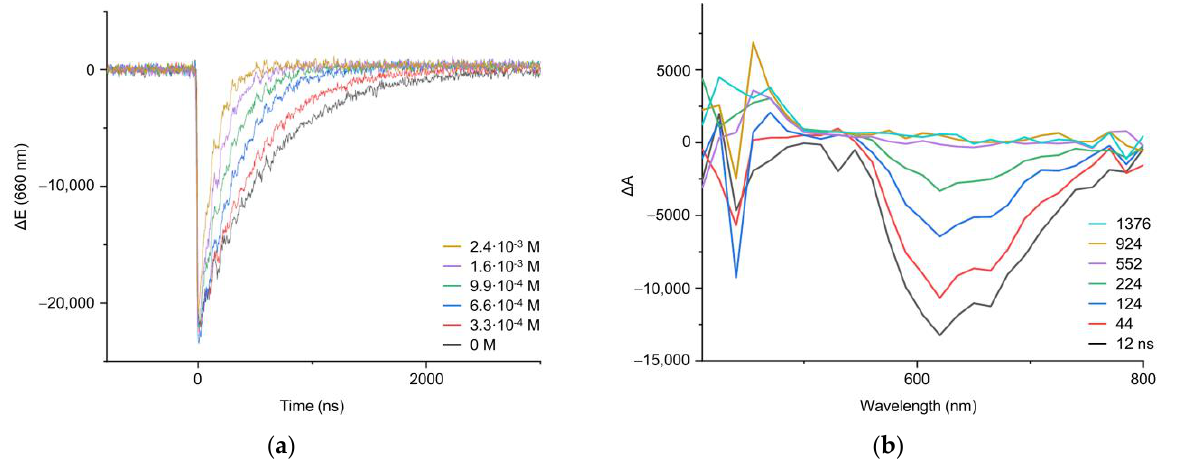
Figure 8. ( a ) Decay traces recorded at 660 nm for [Ru(bpy) 3 ] 2+ (in deoxygenated CH 2 Cl 2 ) after addition of different amounts of 1a , obtained after LFP excitation at 532 nm; ( b ) Transient absorption spectrum of a deoxygenated CH 2 Cl 2 solution of [Ru(bpy) 3 ] 2+ in the presence of 1a (2.4 · 10 − 3 M) registered at different times after laser pulse ( λ exc = 532